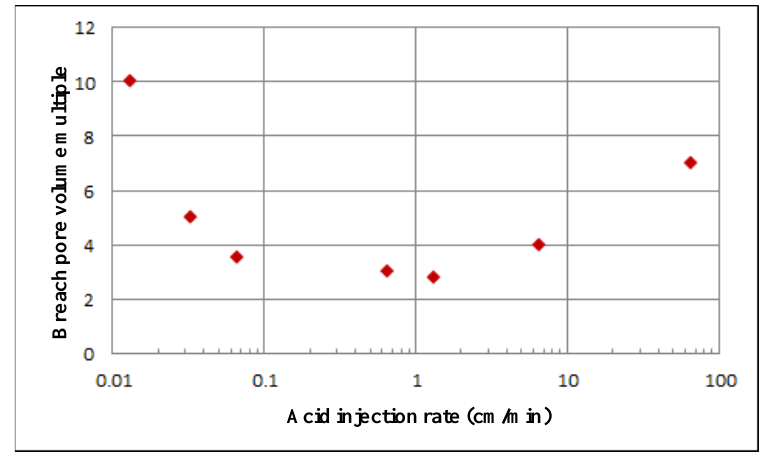
Figure 9. Effect of injection rate on breakthrough volume multiple.